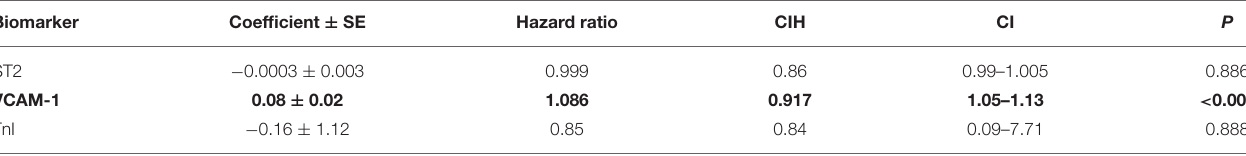
TABLE 3 | Univariate Cox regression for biomarkers, associated with COVID-19 hospital mortality. Biomarker